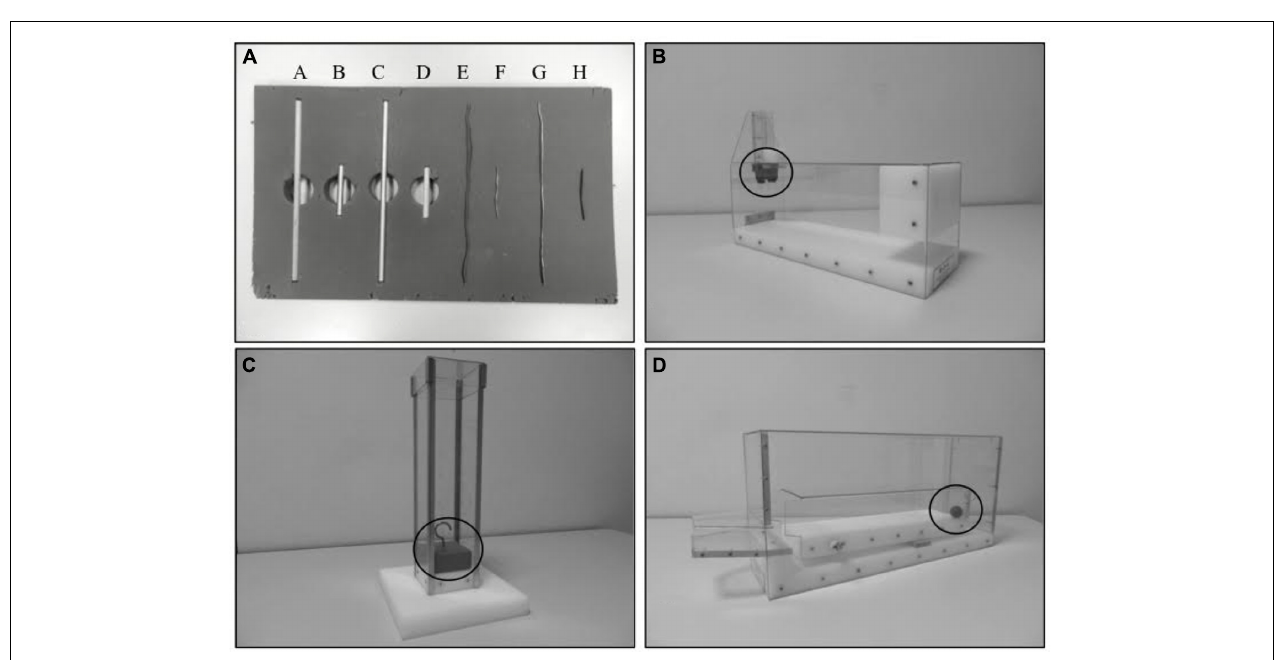
FIGURE 2 | Apparatus and rods used in the mechanical problem solving tasks. The black circles denote the wooden targets that the children had to extract from the boxes (derived from Lesourd et al., 2016). (A) The displayed rods; (B) the Chimney task; (C) the Hook task; (D) the Sloping